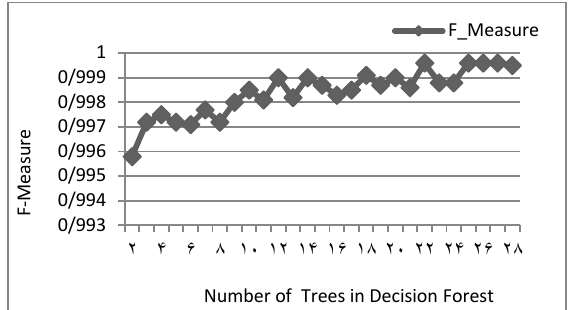
Figure 4. Assessing decision forest with different numbers of trees using F-measure.